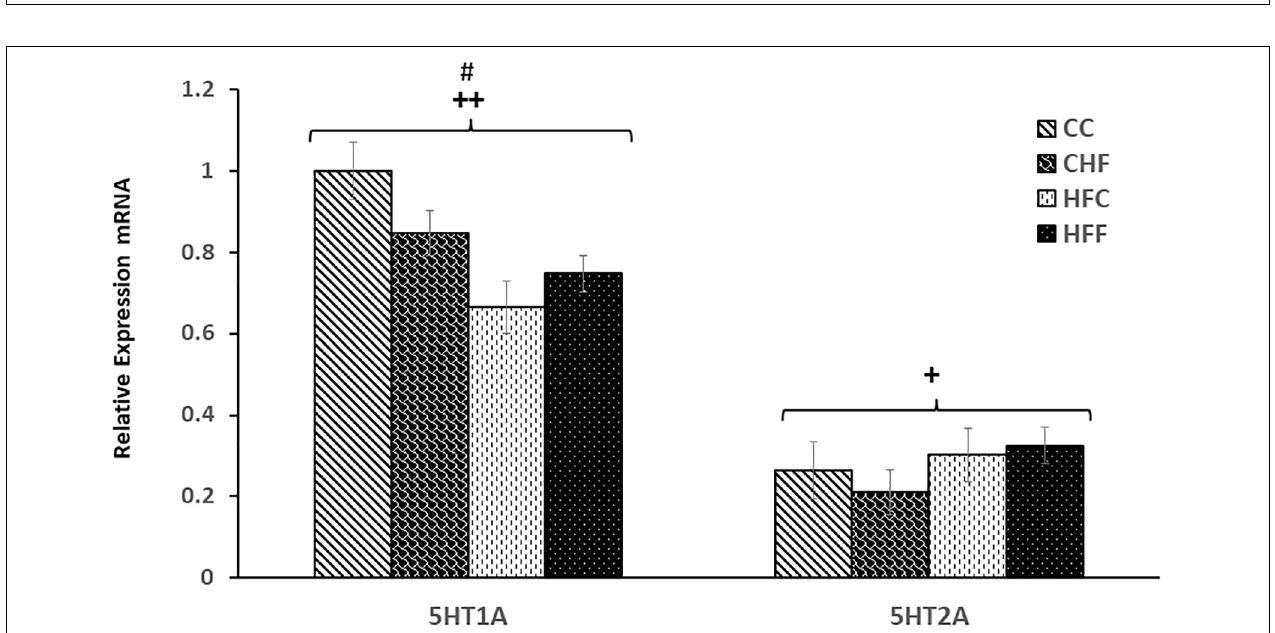
FIGURE 7 | Relative levels of serotonin receptor expression in the Hippocampus. Hippocampal serotonin receptor, 5HT1A and 5HT2A, mRNA expression in the four treatment groups (CC, CHF, HFC, HFF) was measured using qRT-PCR analysis. Values are expressed in relative units where the CC group is set to 1. Serotonin receptor 1A (5HT1A) mRNA expression was significantly reduced in response to both maternal diet (5HT1A, F ( 3 , 39 ) = 7.13; P = 0.007) and post-weaning diet ( F ( 3 , 39 ) = 6.49; P = 0.027). In contrast, an increase in 5HT2A receptor was detected only in response to the maternal diet ( F ( 3 , 39 ) = 7.28; P = 0.039). No significant interaction was detected between maternal and post-weaning diet using two-way ANOVA. Values are means + SEM ( n = 16 for each group). + P < 0.05, ++ P < 0.01 (significant maternal diet effect); # P < 0.05 (significant post-weaning diet effect).